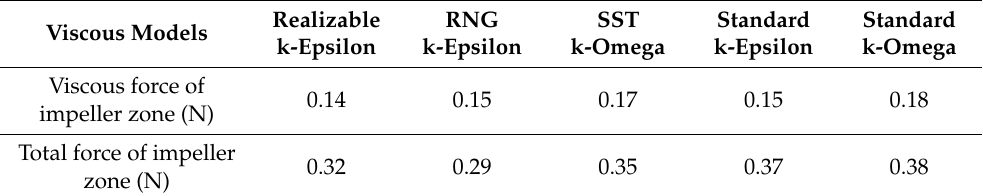
Table 1. Simulation results comparison between different